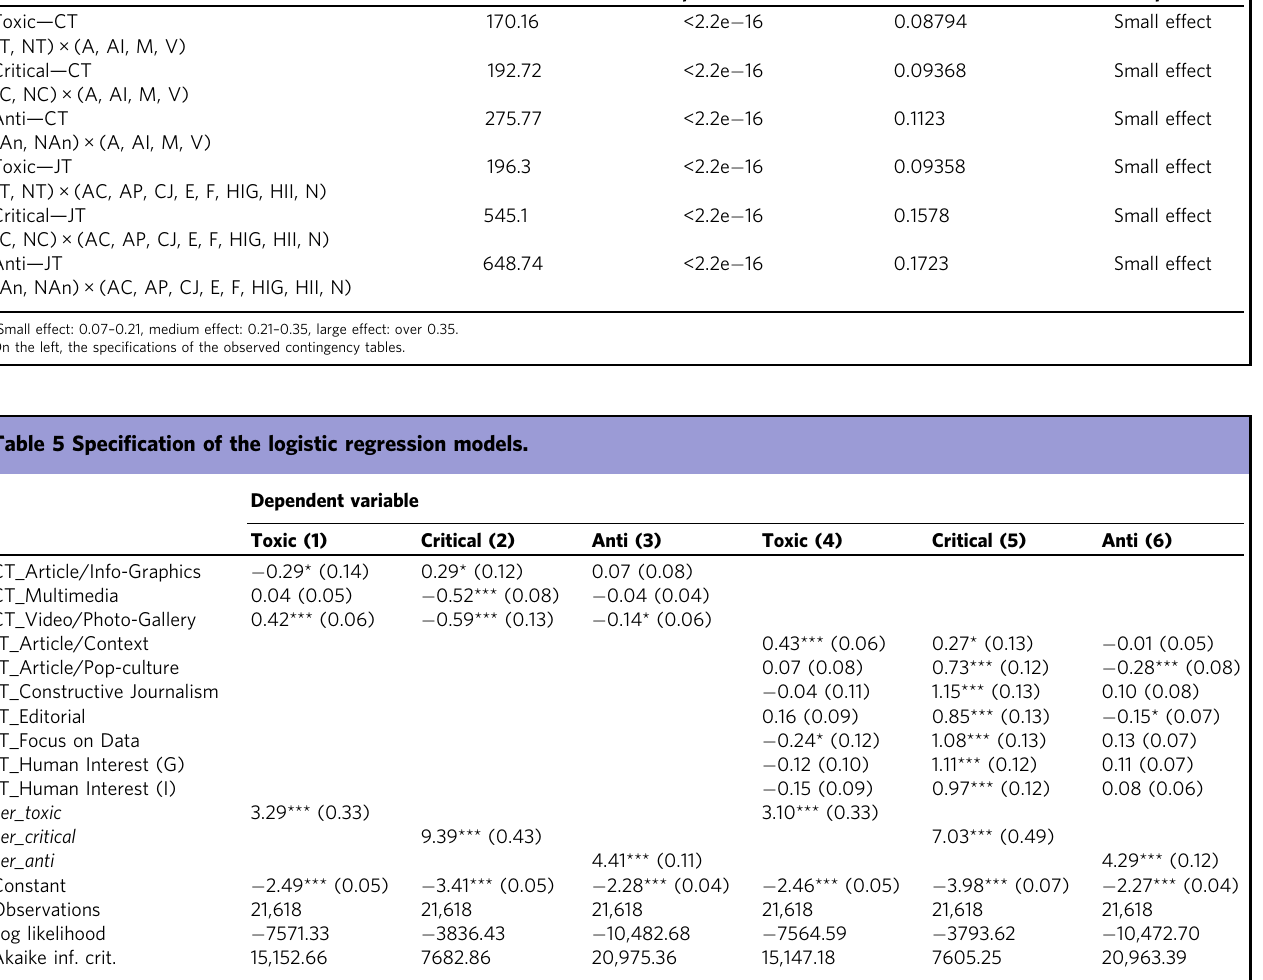
Table 5 lists the parameters of our logistic regression models. Models 1 – 3 generate the probabilities of fi nding toxic, critical, or anti-migration comments, respectively, in four different CTs.